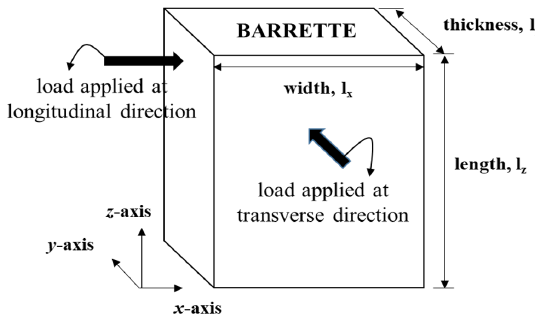
Fig. 1. Layout of the barrette and its dimensional